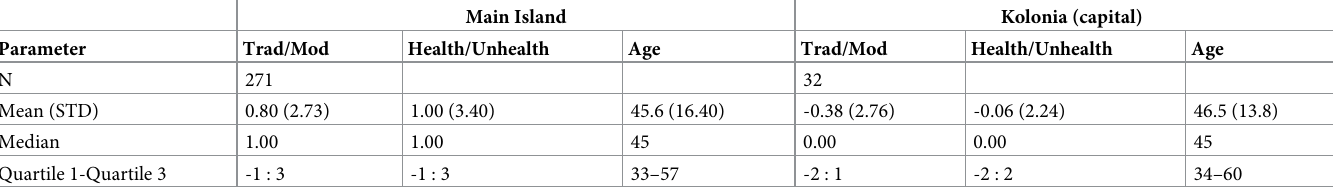
Table 3. Traditional-Modern and Healthy-unhealthy scale scores of the capital, Kolonia compared with the whole main island